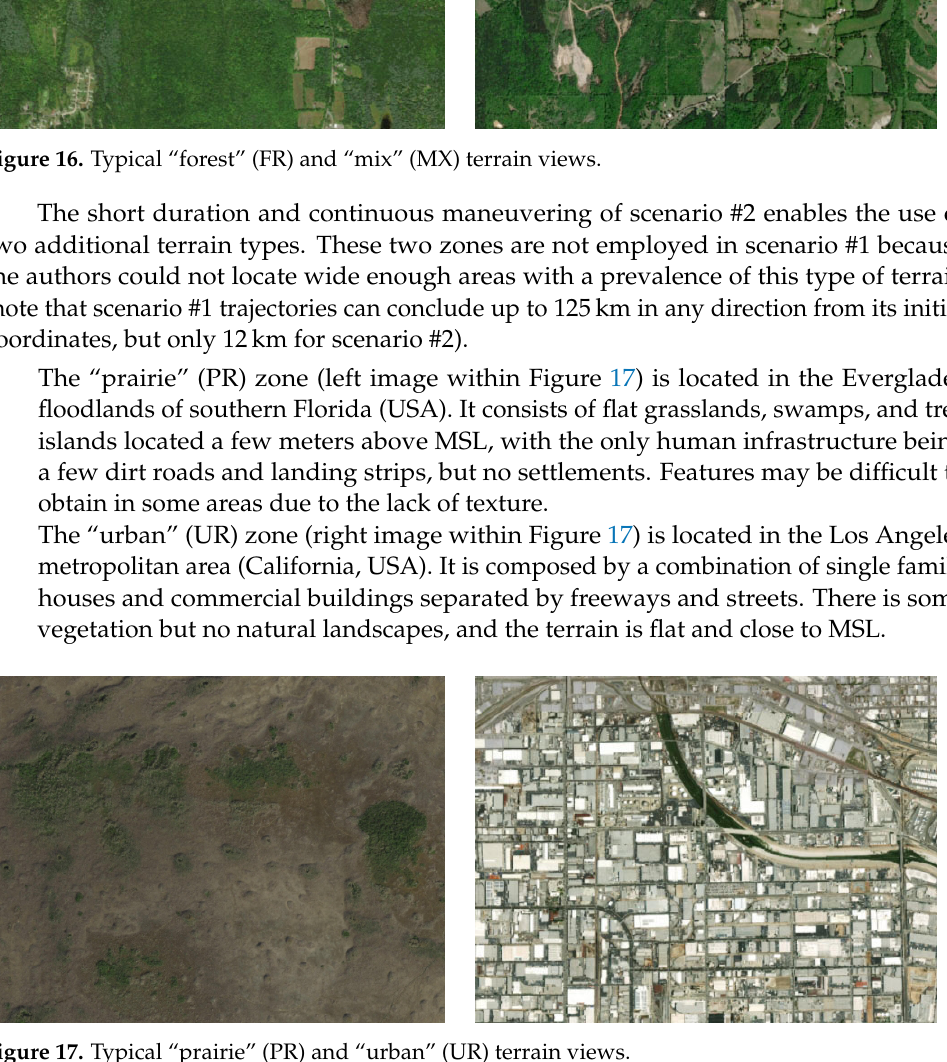
Figure 17. Typical “prairie” (PR) and “urban” (UR) terrain